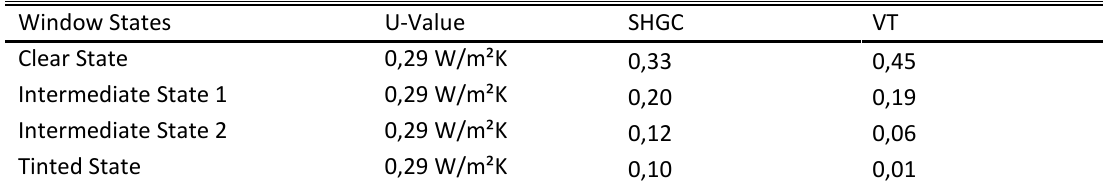
Table 5 Optical properties of electrochromic windows per state.